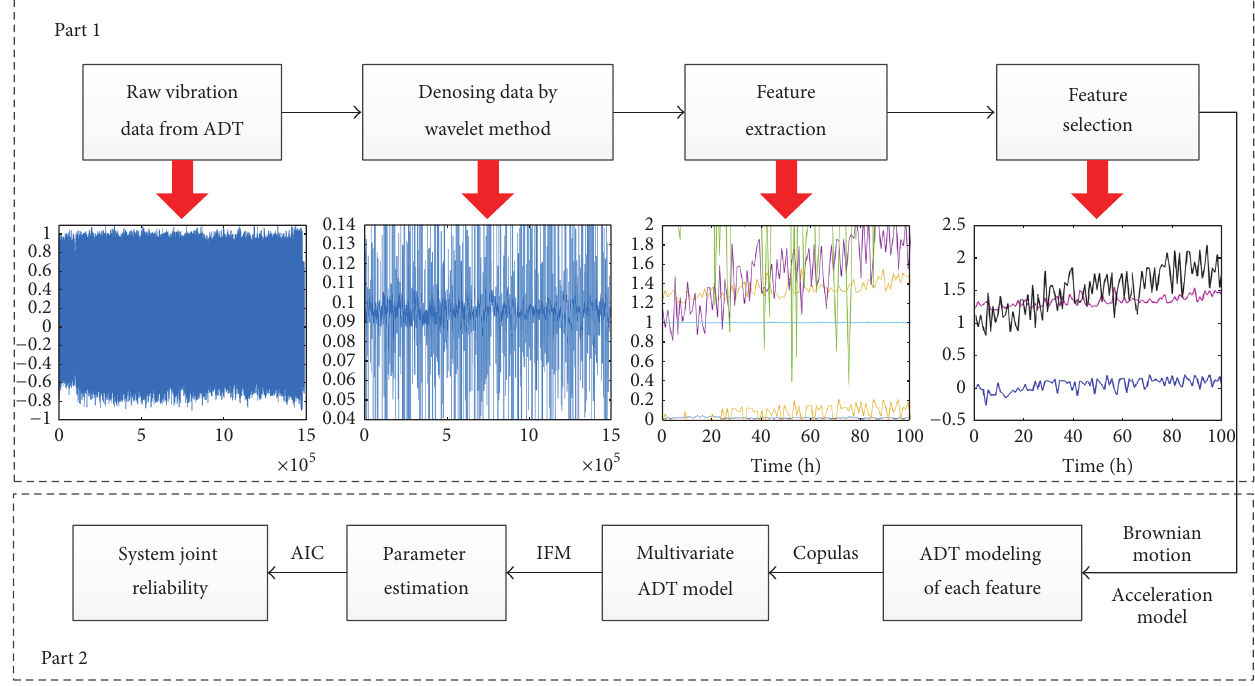
Figure 1: The framework of reliability and life evaluation for vibration-based